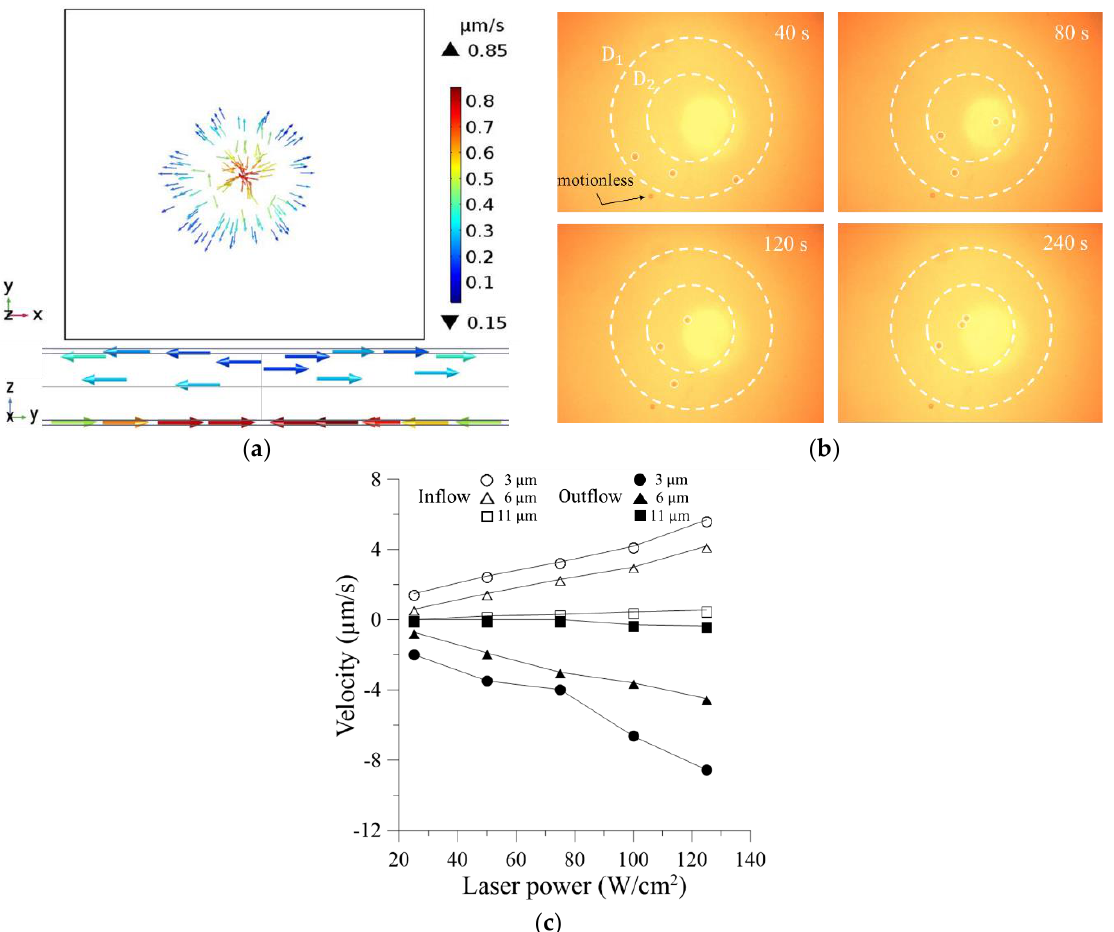
Figure 6. ( a ) Numerical results for velocity field. ( b ) Experimental results for trapping of polystyrene beads with diameter of 11 μm at 40, 80, 120 and 240 s, respectively. Note that the laser power is 75 W/cm 2 , the voltage amplitude is 35 V pp , and the driving frequency is 25 kHz. ( c ) Variation of particle velocity with laser power as function of particle size.